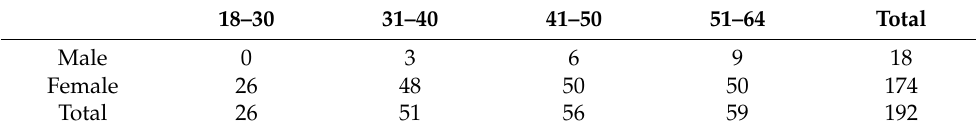
Table 2. Respondents’ age and gender.